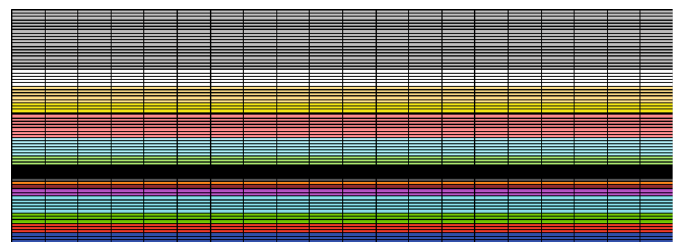
Figure 3: Physical